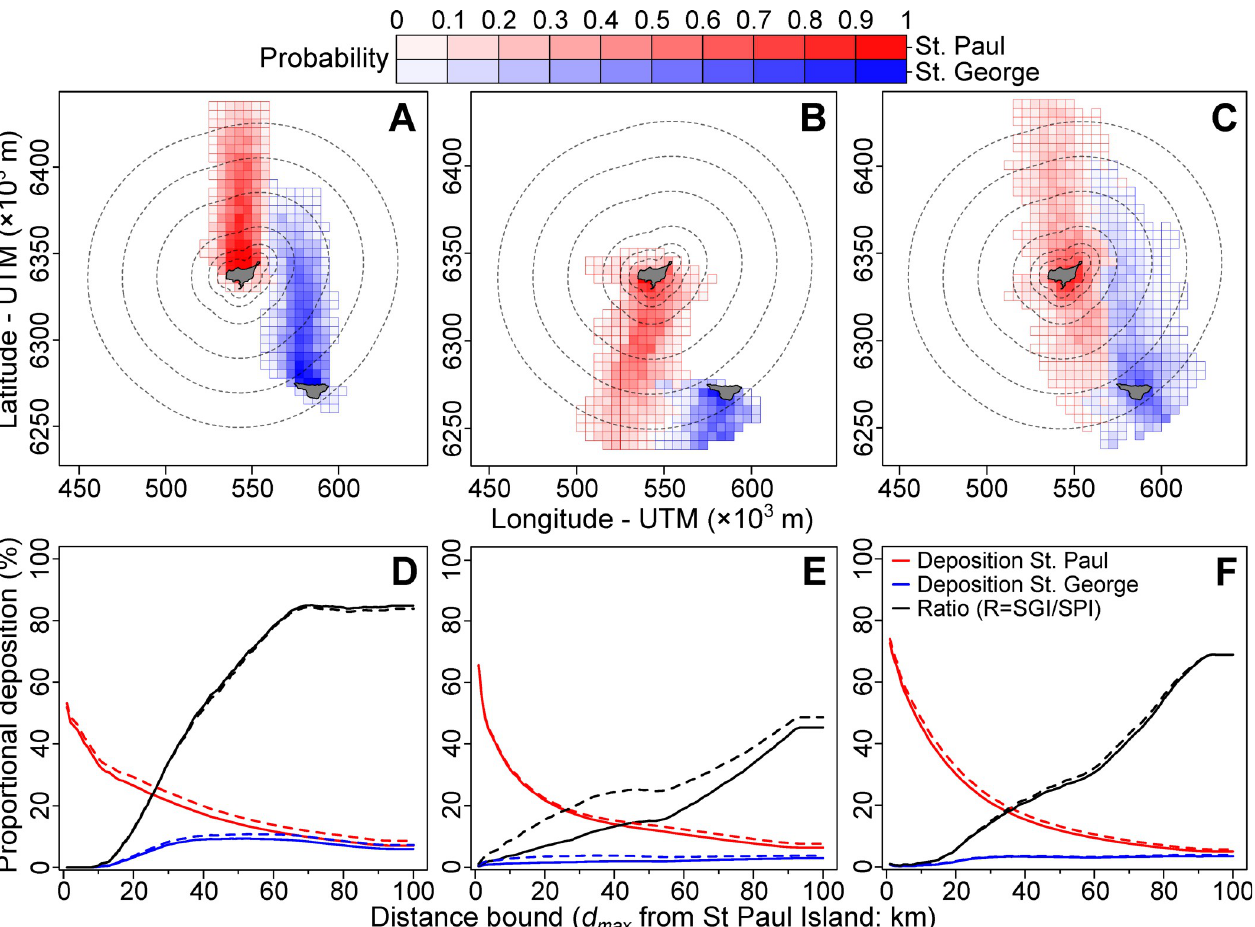
Fig 5. Probability of carcass deposition as a function of location and distance from St. Paul (SPI) and St. George (SGI) Islands, Alaska. Probability of carcass deposition as a function of start location (A-C; median float duration = 7 days), and proportional deposition as a function of the assumed at-sea distribution, proxied by maximum distance, d max , from SPI (D-F), are explored for carcasses deposited between 17 to 21 October 2016 (A & D), 27 October to 1 November 2016 (B & E) and 15 to 23 November 2016 (C & F). Dashed contours in A-C indicate distances of 5, 10, 20, 40, 60 and 80 km from the SPI coastline. Solid/dashed lines in D-F represent results from alternate formulations of float duration (solid = 7 day scenario, dashed = 9 day scenario).